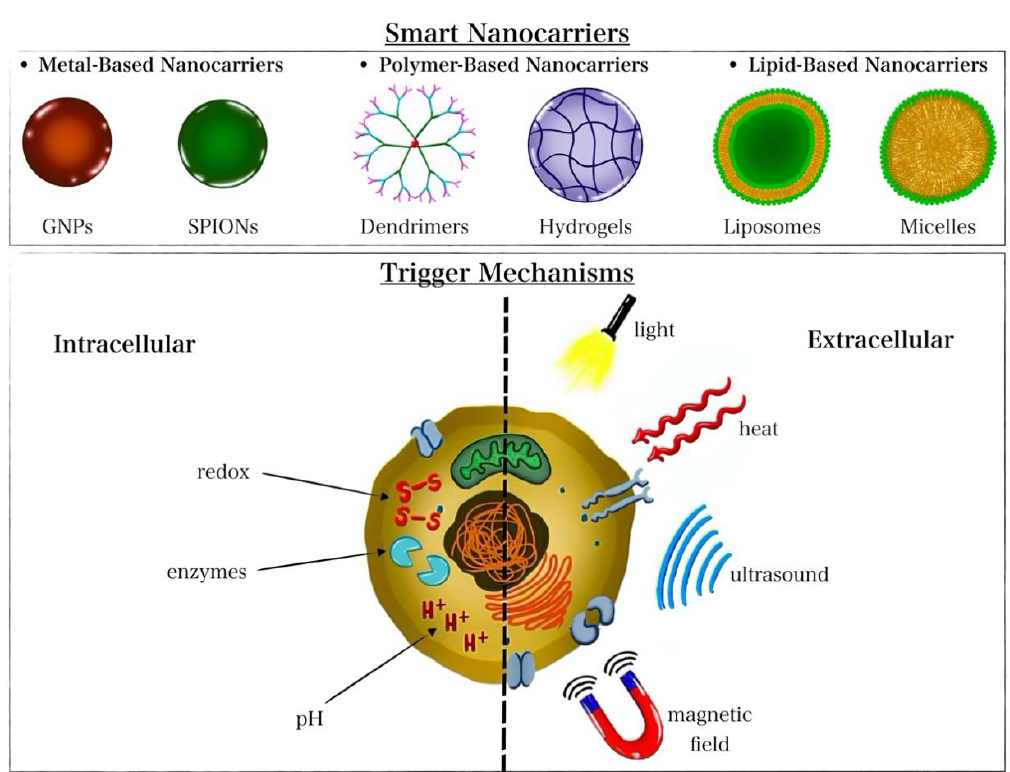
Figure 2. Illustration of the different nanocarrier types and release-triggering mechanisms.